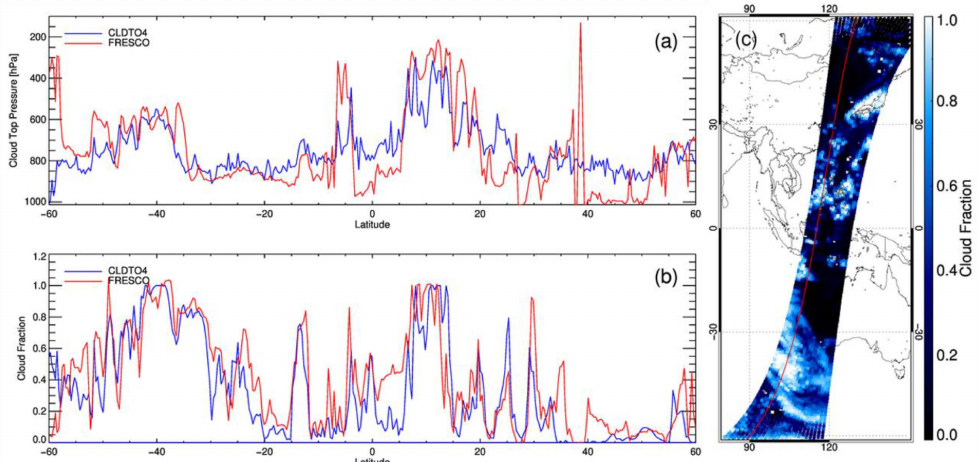
Figure 6. Intercomparison of ( a ) CTP and ( b ) CF was retrieved from CLDTO4 and FRESCO. The cross-section is a GOME-2 orbit as a function of the latitude from 0108 to 0250 UTC on 20 September 2016. ( c ) The trajectory of the over-passed track of GOME-2. The track line used in ( a , b ) is represented as a red line. The overlapped background image is the CF of CLDTO4.